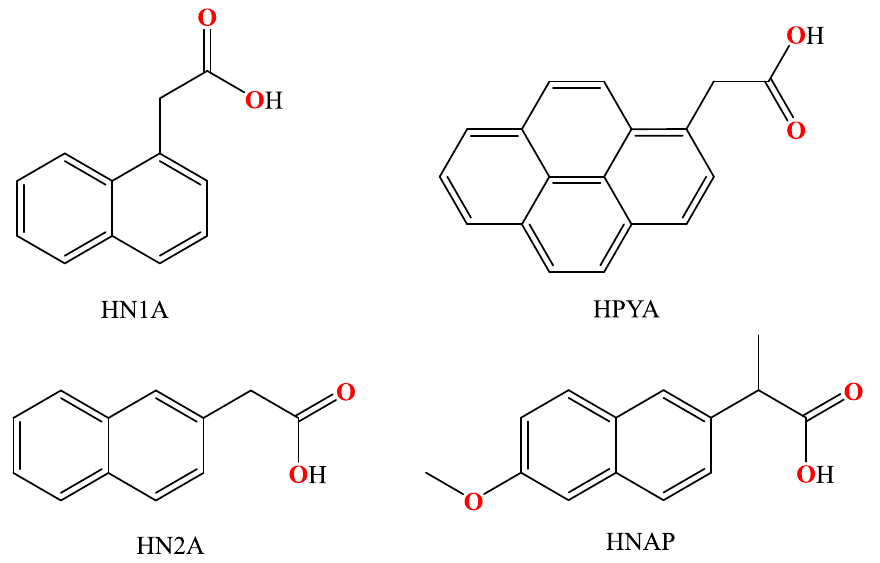
Figure 2. The syntax formula of 1–naphthylacetic acid (= HN1A), 2–naphthylacetic acid (= HN2A), naproxen (= HNAP) and 1–pyreneacetic acid (= HPYA).